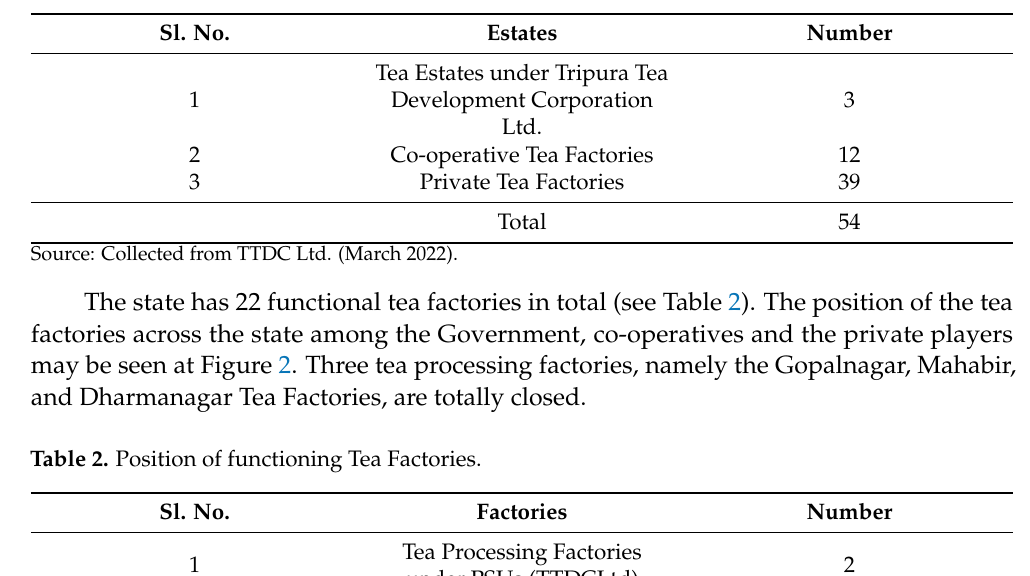
Table 1. Position of Tea Estates in Tripura. Sl. No. Estates Number Tea Estates under Tripura Tea 1 Development Corporation Ltd. 2